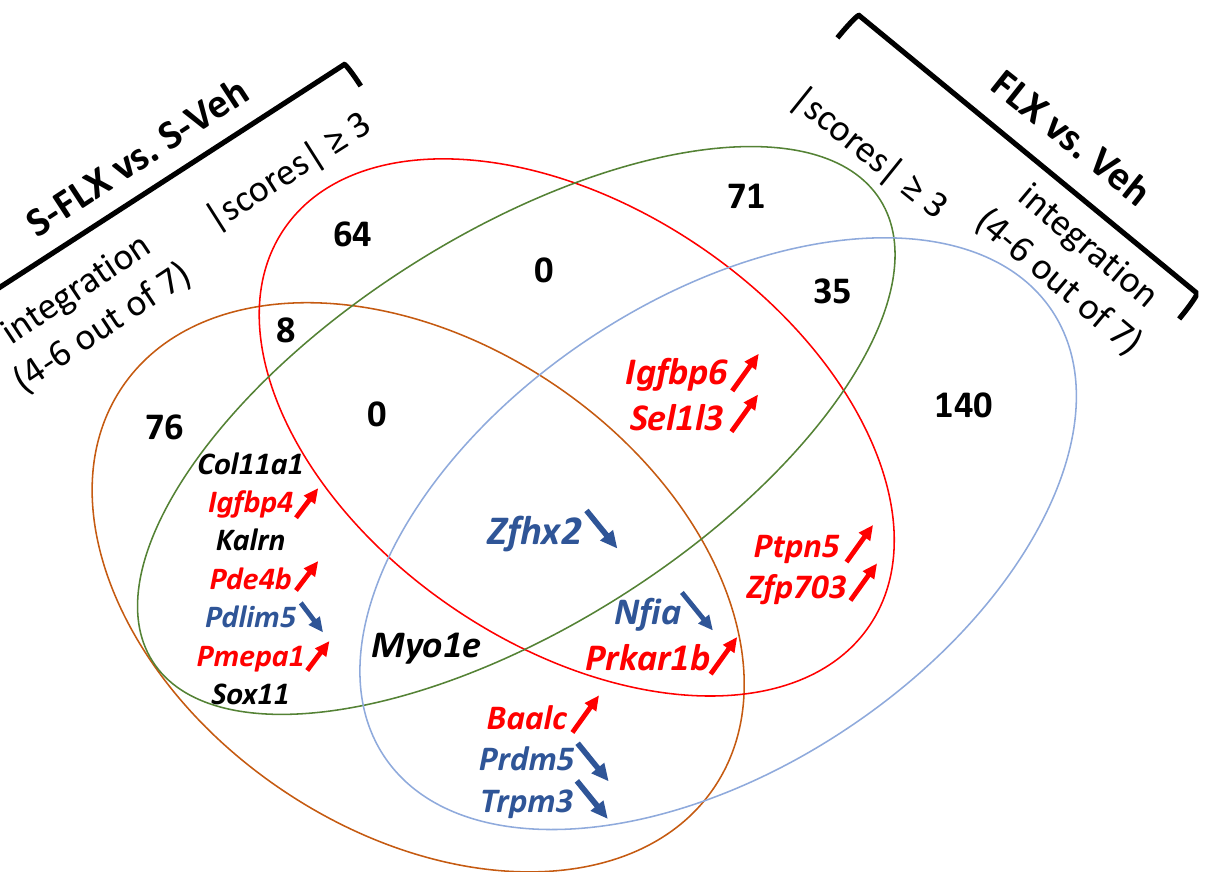
Figure 3. Venn diagram of hippocampal transcriptional signatures. The signatures were induced by either FLX in a stress-inducing depressive-like behavior paradigm (S-FLX vs. S-Veh) or FLX in naïve rodents (FLX vs. Veh) and the list of genes were obtained by either integration (significant in at least four experiments) or scoring methods (both consensus and portrait). Genes in red are generally overexpressed, genes in blue are downregulated whereas genes in black show no consensual trend of variation direction. Table 9. Ontological analysis of upregulated genes (consensus and portrait scores ≥ 4) after FLX treatment.